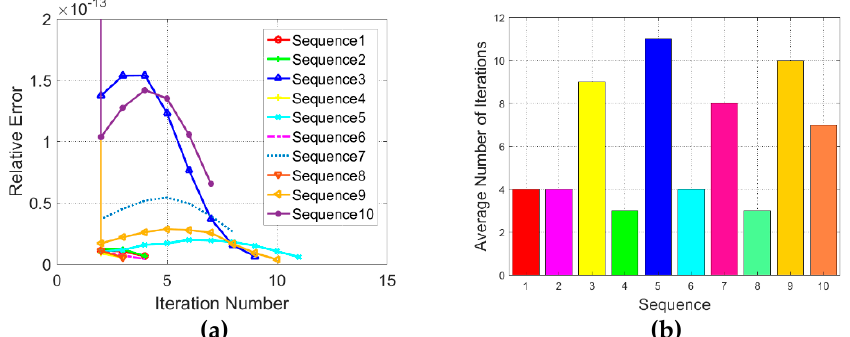
Figure 12. The empirical convergence analysis of the proposed method based on average number of iterations over 10 sequences. ( a ) Convergence curves. ( b ) Average number of iterations.